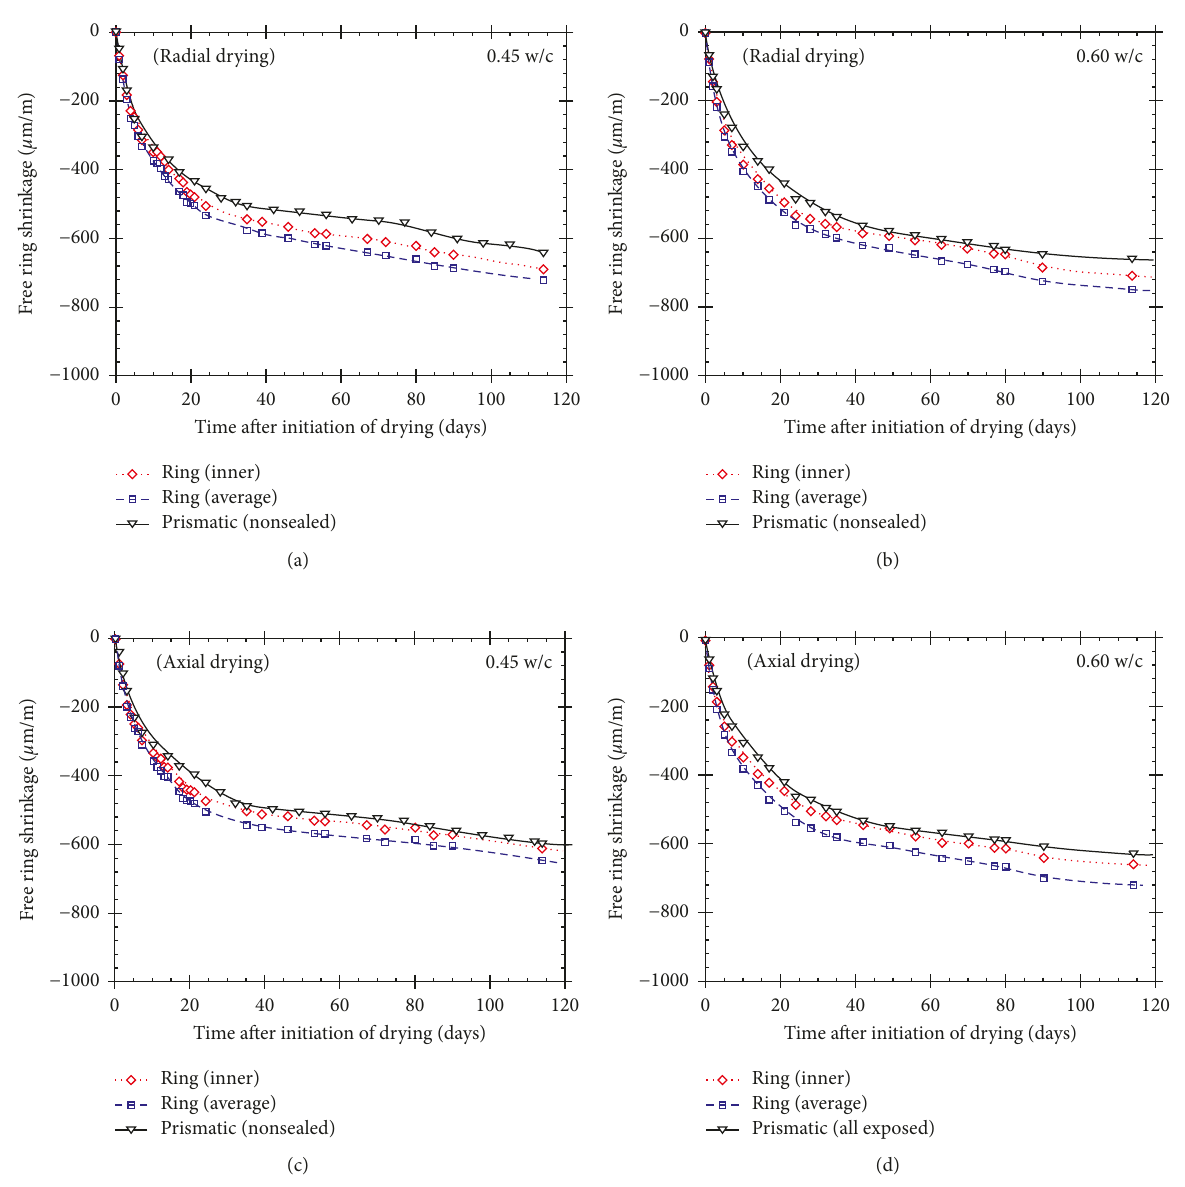
Figure 9: Free shrinkage recorded on prismatic and ring specimens with equal S/V ratio. (a) w/cm 0.45 radial drying specimen, (b) w/cm 0.60 radial drying specimen, (c) w/cm 0.45 axial drying specimen, (d) w/cm 0.60 axial drying